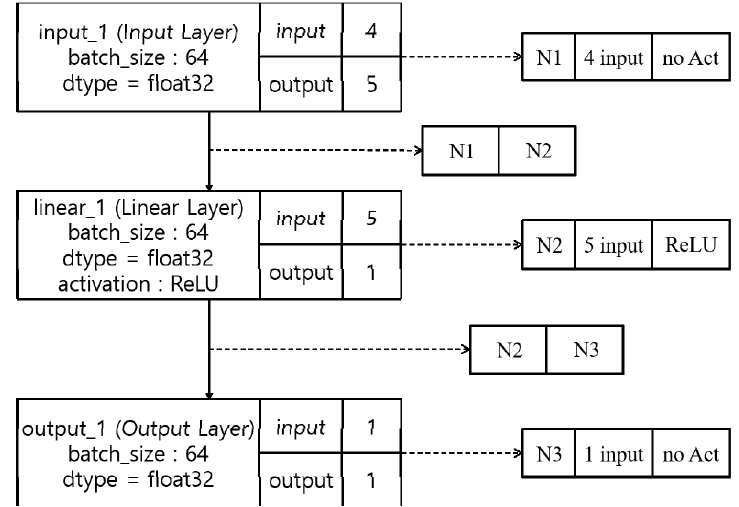
Figure 5. Initial architecture. Table 3. Parameters of